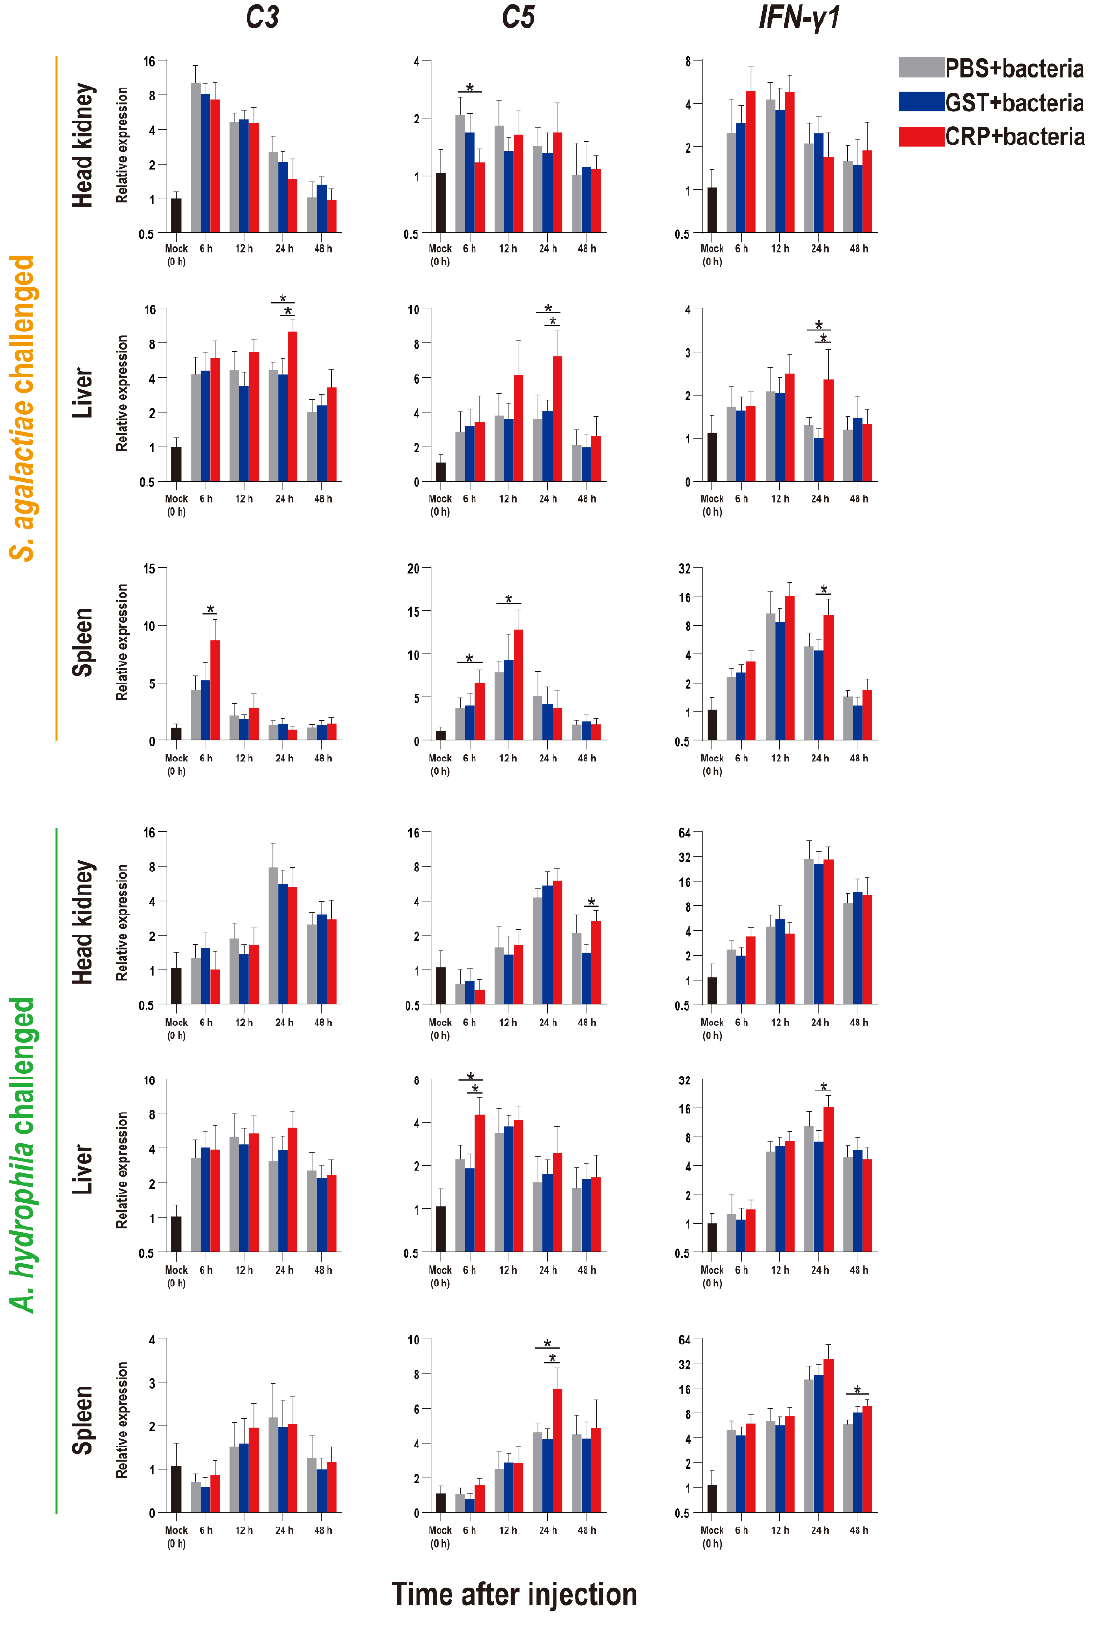
Figure 6. Expression patterns of complements ( C3 and C5 ) and interferon ( IFN- γ 1 ) as assessed via qRT-PCR at different time points post S. agalactiae and A. hydrophila infection. All values are the mean ± SD; n = 3. Significant difference is indicated by asterisks ( p < 0.05).